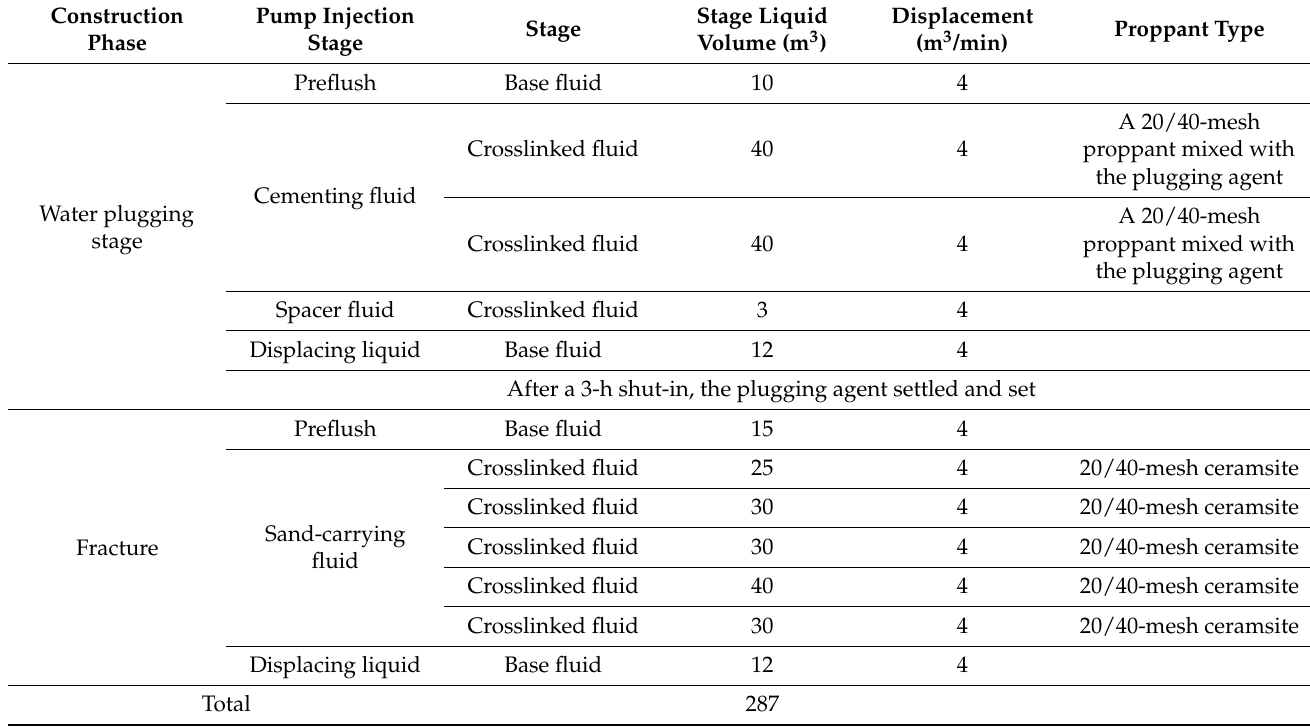
Table 10. Fracturing treatment pump injection